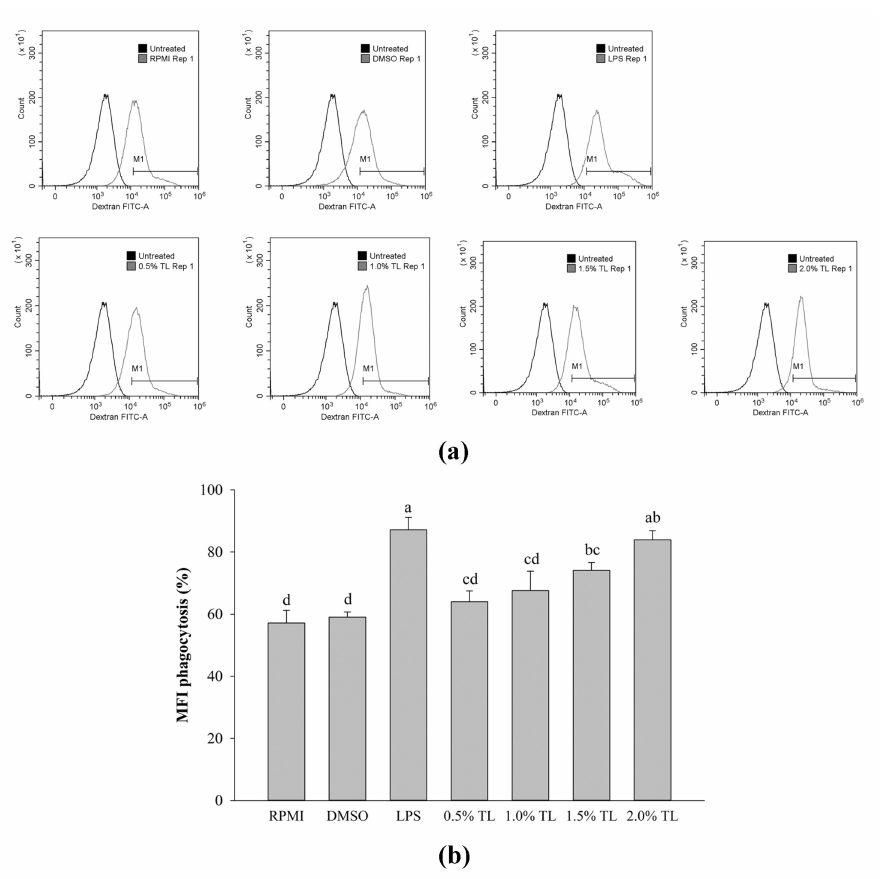
Figure 4. The effects of lipid extracted from A. personatus eggs on phagocytosis of RAW264.7 cells. ( a ) Flow cytometry analysis of FITC–dextran uptake and ( b ) percentage of mean fluorescence intensity (MFI). Data are presented as means ± standard deviation ( n = 3). The letters a, b, c, and d indicate significant differences ( p < 0.05) between treatment groups. M1 = classically activated macrophage phenotype (related to immune stimulation activity) and TL = total